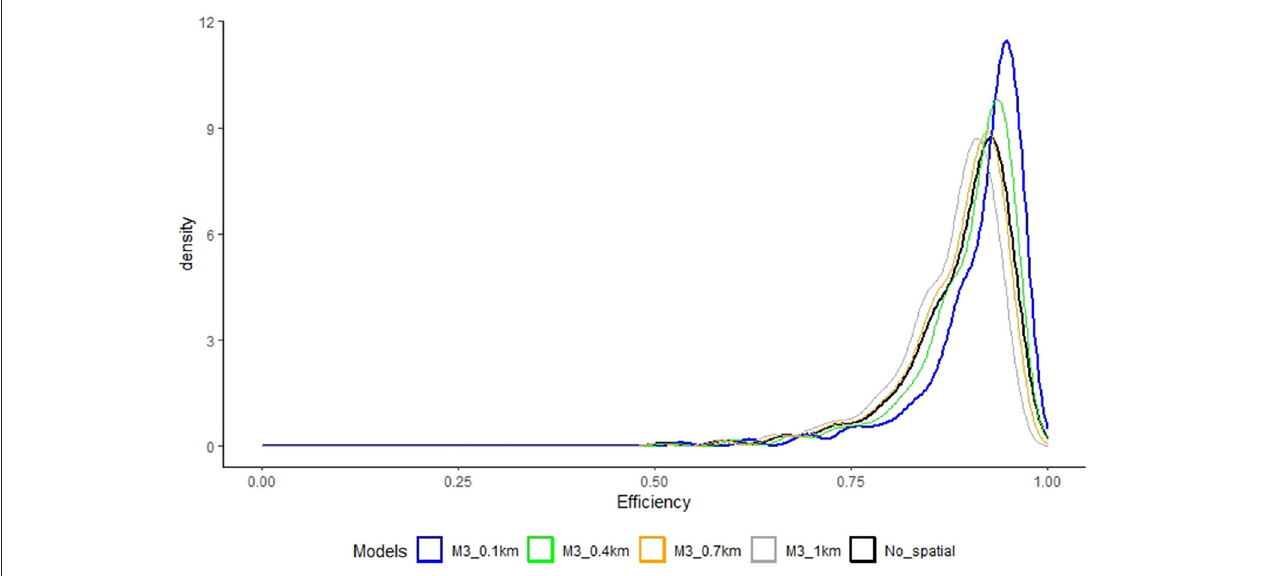
FIGURE 8 | Model 3 vs. non spatial: Farm technical efficiency distribution for irrigated farms at different cut-off distances.